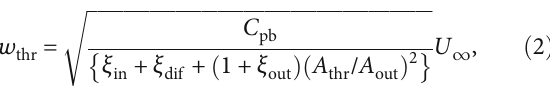
Figure 8: Pressure distributions in the towers (experimental